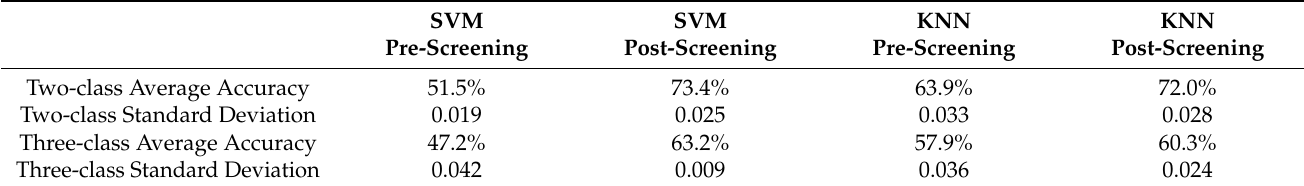
Table 2. The average accuracy and standard deviation of the test set for multiple verifications of